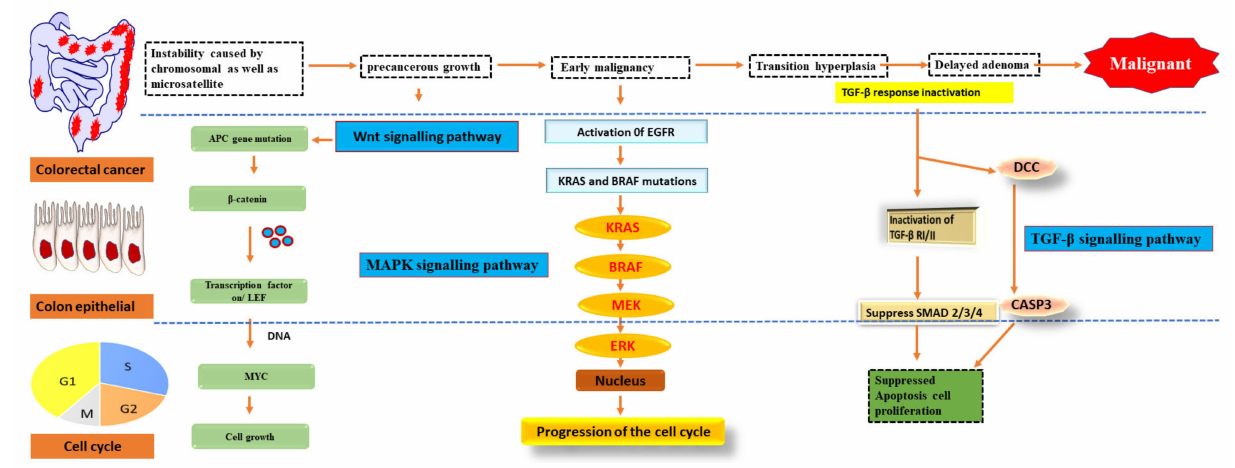
Figure 2. Pathways of signalling that have been genetically changed by